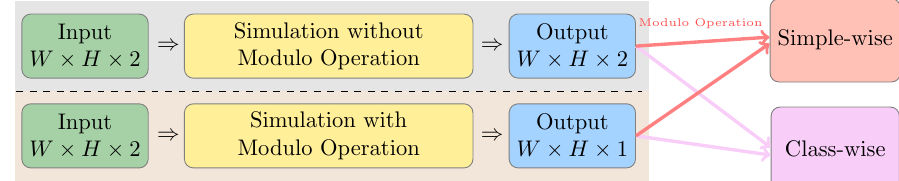
Figure 10. Sketch map of assessment in the complex field.